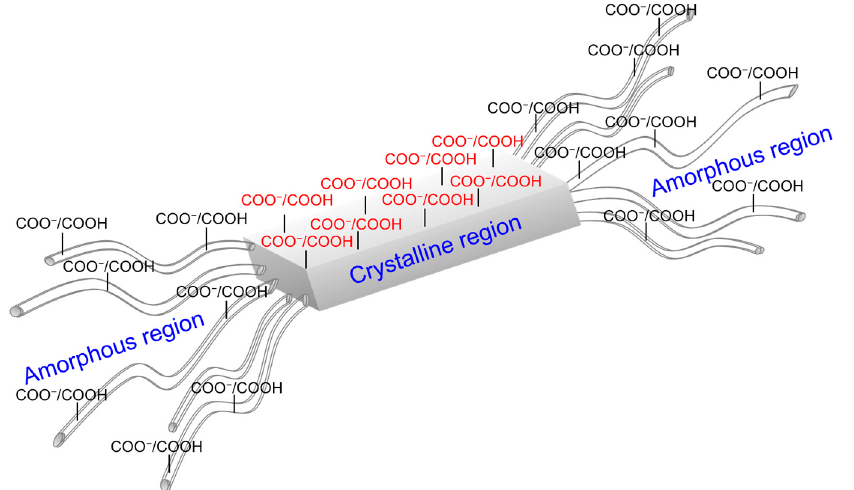
Figure 6. Schematic representation of the crystalline and amorphous domains of TEMPO-oxidized cellulose nano-fibers. Black and red COO − /COOH account for carboxyl functional groups of amorphous and crystalline regions, respectively. In this drawing, the bPEI segments were intentionally omitted.